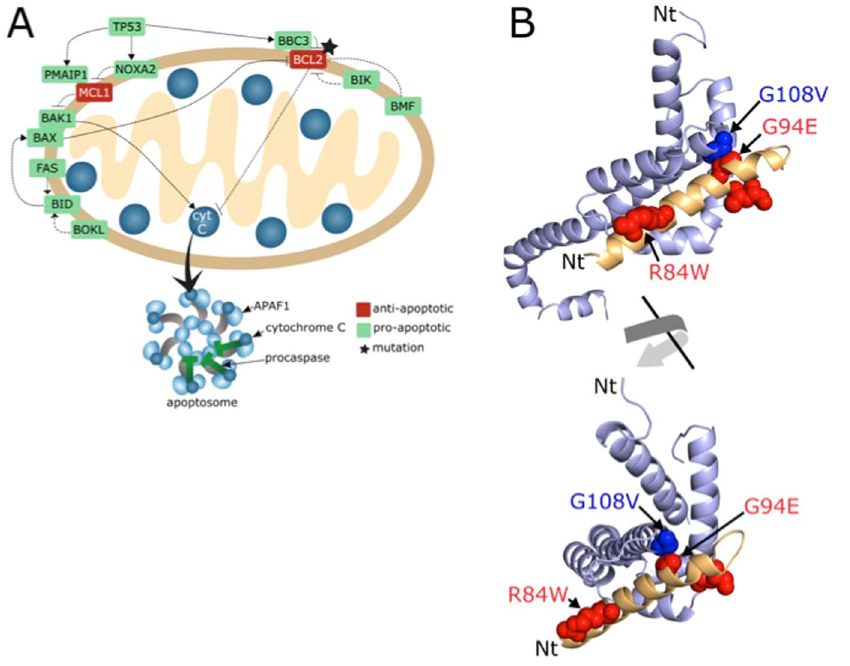
Figure 7. Proposed molecular mechanism underlying Alzheimer’s and neoplasms comorbidity. ( A ) Diagram of mitochondrial meditated apoptosis and TP53. Representation of the apoptosis pathway. Note that most genes cited in the text are pro-apoptotic molecules. ( B ) Interaction between the apoptosis regulator BAX and BH3-interacting domain death agonist BID. Cartoon representation of BAX (light blue) and BID (light orange) protein complex. Residues associated with mutations involved in neoplasm are shown in sphere representation in red for BID (L105P, R84W and G94E) and in blue for BAX (G108V). It is worth noting that G108 in BAX faces G94 in BID and that R65L mutation is not detected in the structure of the